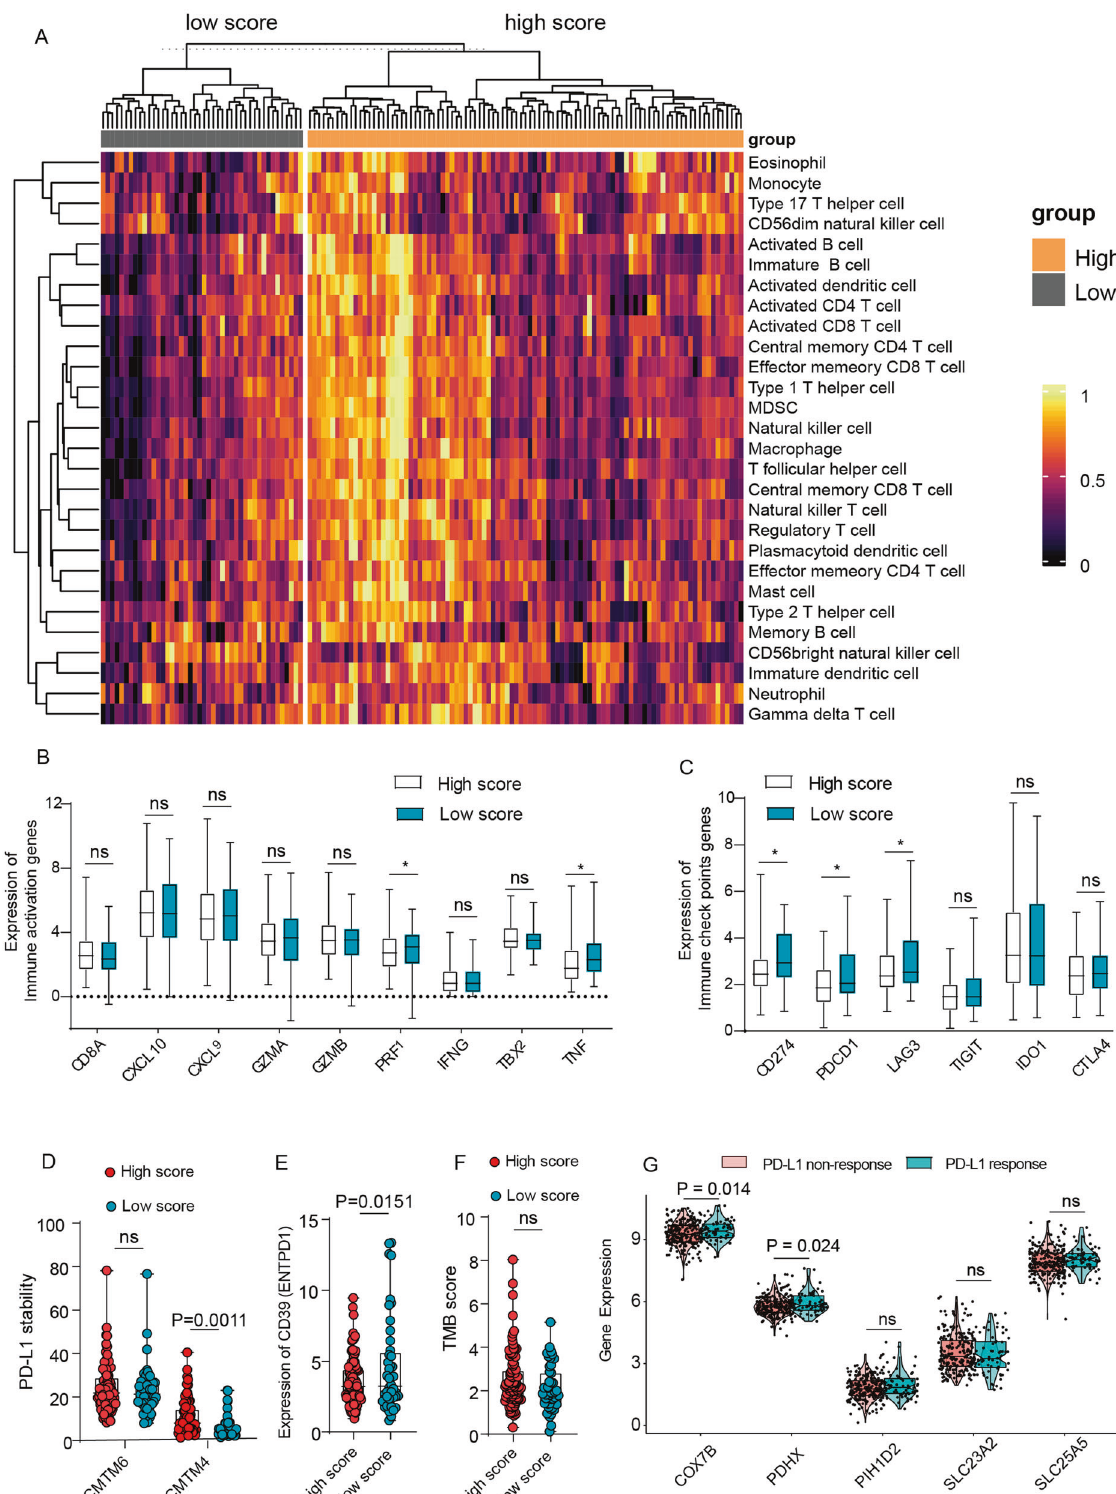
Fig. 8 Higher CRGs score was associated with more immune in fi ltration, PD-L1 stability, and more proportion of bystander T cells. A The heatmap showed the immune in fi ltration status between the high-CRGs score group and the low-CRGs score group. B Expression of immune activation genes between high-CRGs score group and low-CRGs score group. C Expression of immune checkpoint genes between high-CRGs score group and low-CRGs score group. D Expression of PD-L1 stability genes (CMTM6, CMTM4) between high-CRGs score group and low- CRGs score group. E Expression of bystander T cell genes (CD39) between high-CRGs score group and low-CRGs score group. F Tumor mutation burden (TMB) score between high-CRGs score group and low-CRGs score group. G Expression of CRGs between response and non- response patients that received PD-L1 inhibitor treatment in the IMvigor210 (mUC) cohort. Data was exhibited as mean ± SD. Signi fi cance were assessed by two-tailed t -test ( B – G ). ns = not signi fi cant, * P < 0.05; ** P < 0.01; *** P < 0.001. Cell Death Discovery (2022)